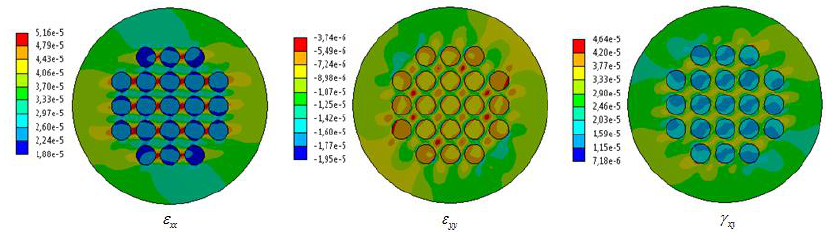
Fig. 10. Microstrains.